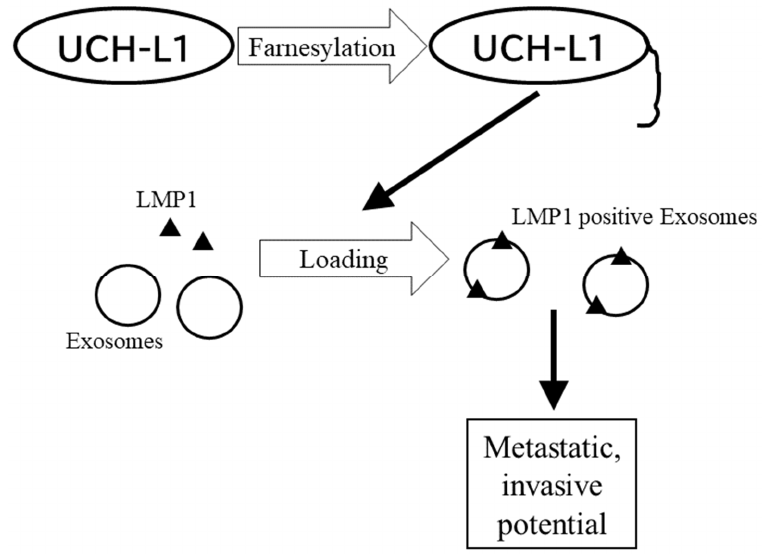
Figure 4. Farnesylation in metastasis and invasion of NPC in drug resistance of NPC. Fanesytaion of UCH-L1 plays a role in loading of LMP1 to exosomes. LMP1-positive exosomes promote metastatic, invasive potential of NPC.